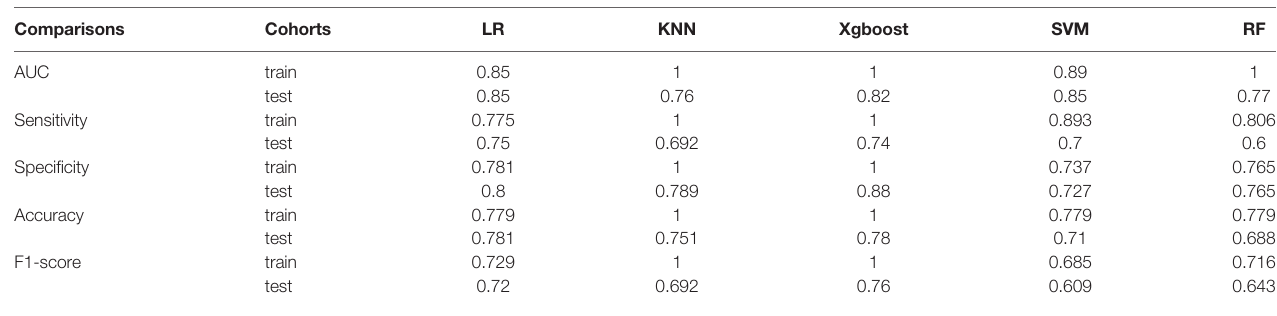
TABLE 3 | The performances of fi ve prediction models.